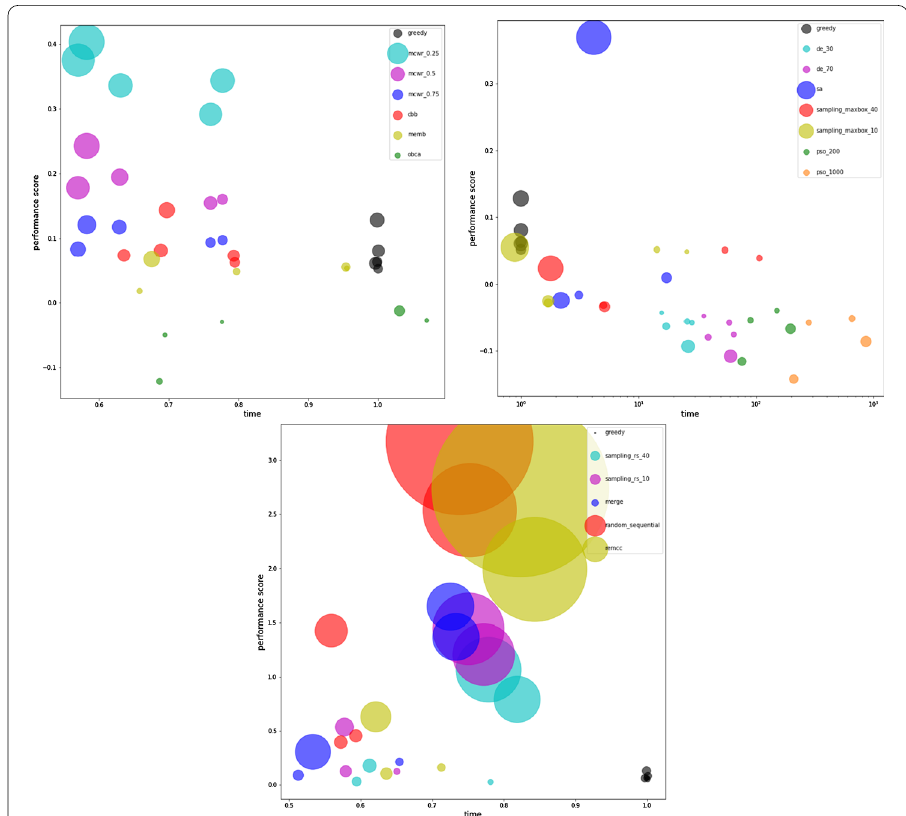
Fig. 7 Scatterplots of mean performance score versus the mean normalized runtime for five networks. To make the figures clearer, we plotted the data in three subplots and added greedy as a reference to all subplots. On the first subplot, the relatively accurate and fast algorithms are depicted. On the second subplot, we can see the slower algorithms. Here behold that the normalized time is on a logarithmic scale. On the third subplot, the relatively inaccurate algorithms are